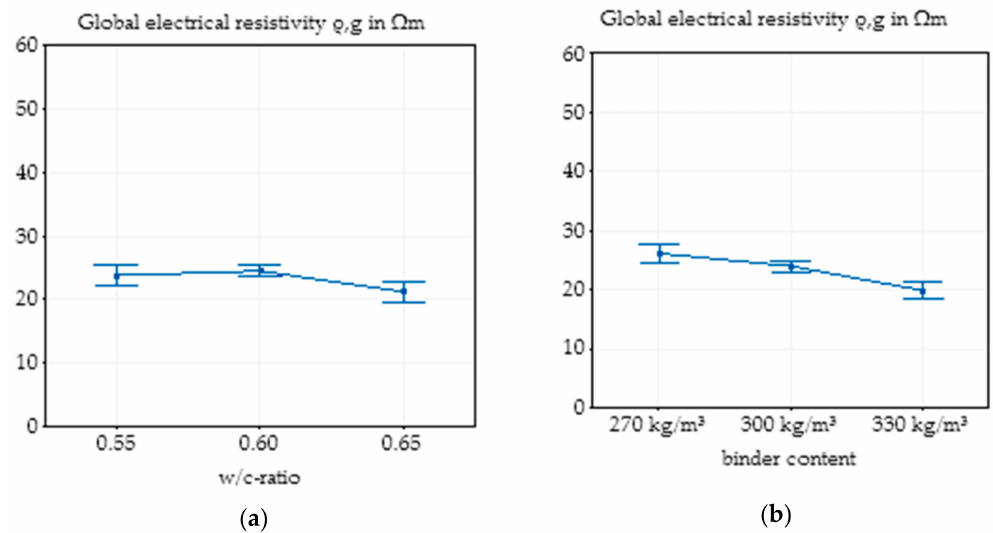
Figure A2. Main effect plot with 95% confidence interval of the w/c ratio on the global electrical resistivity of SFRC calculated by Minitab based on all experimental data ( a ) and main effect plot with 95% confidence interval of the binder content on the global electrical resistivity of SFRC calculated by Minitab based on all experimental data ( b ).